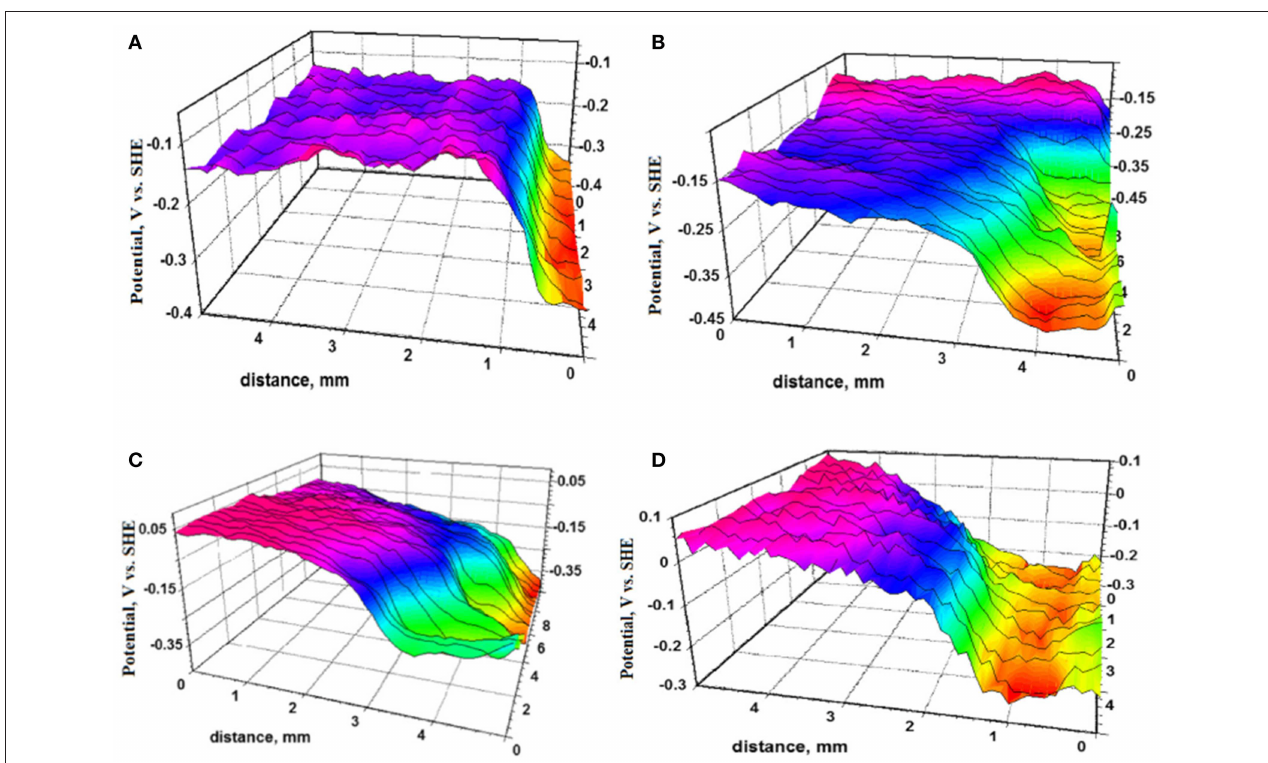
FIGURE 10 | Substrate: structural steel S355MC; Primer pigment: Zinc, with topcoat. Samples were exposed to accelerated testing in 3 wt.% NaCl at 95% relative humidity and were removed to characterize the potential profile of the scribe/coating interface via SKP after (A) 2 days, (B) 8 days, (C) 13 days, and (D) 23 days of exposure (Feliu et al., 2001). Reproduced with